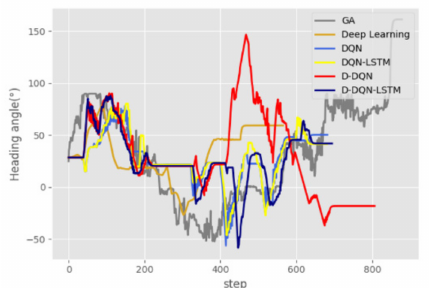
Figure 20. Heading angle curves of six algorithms in a complicated environment.